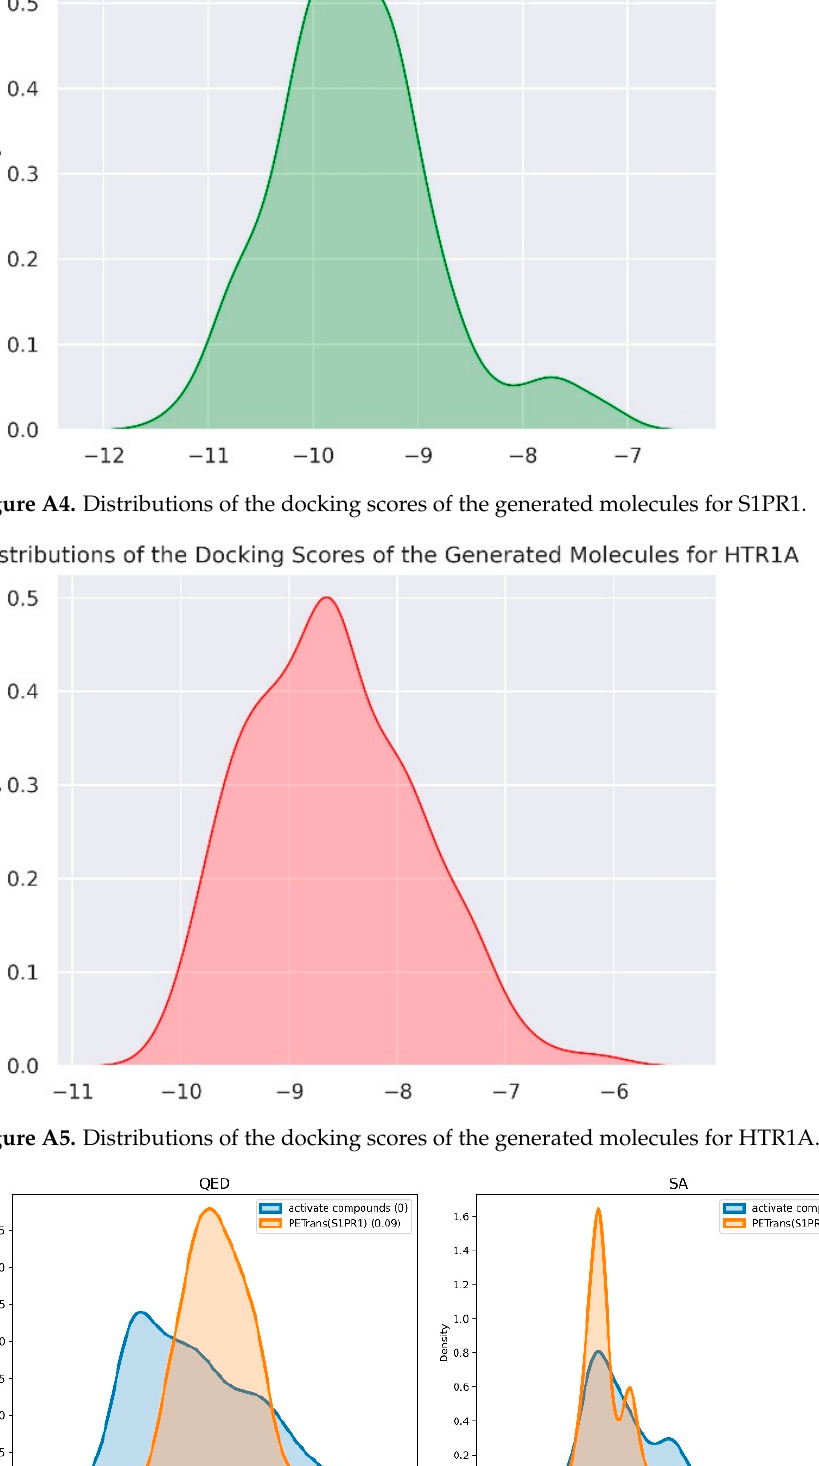
Figure A6. Distribution of the SA scores and the QED scores of the generated molecules for S1PR1.